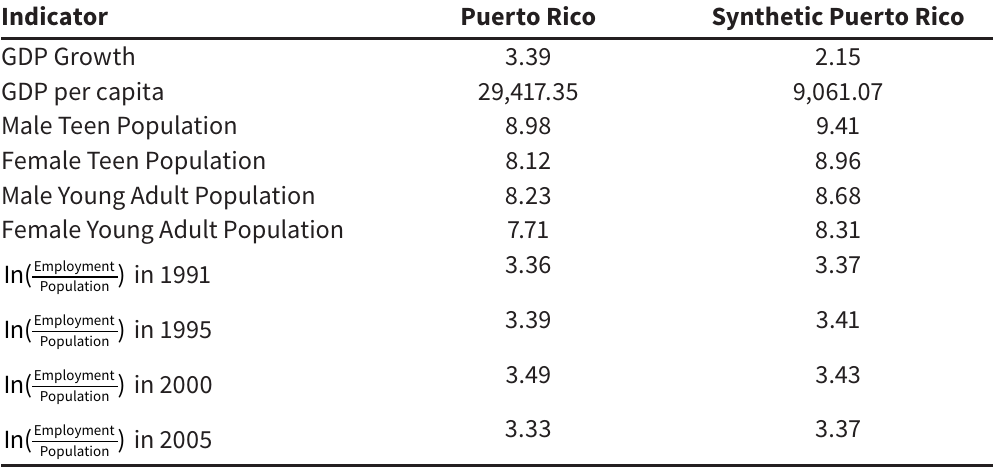
Indicators in Puerto Rico vs. Synthetic Puerto Rico (Limited Donor Pool)